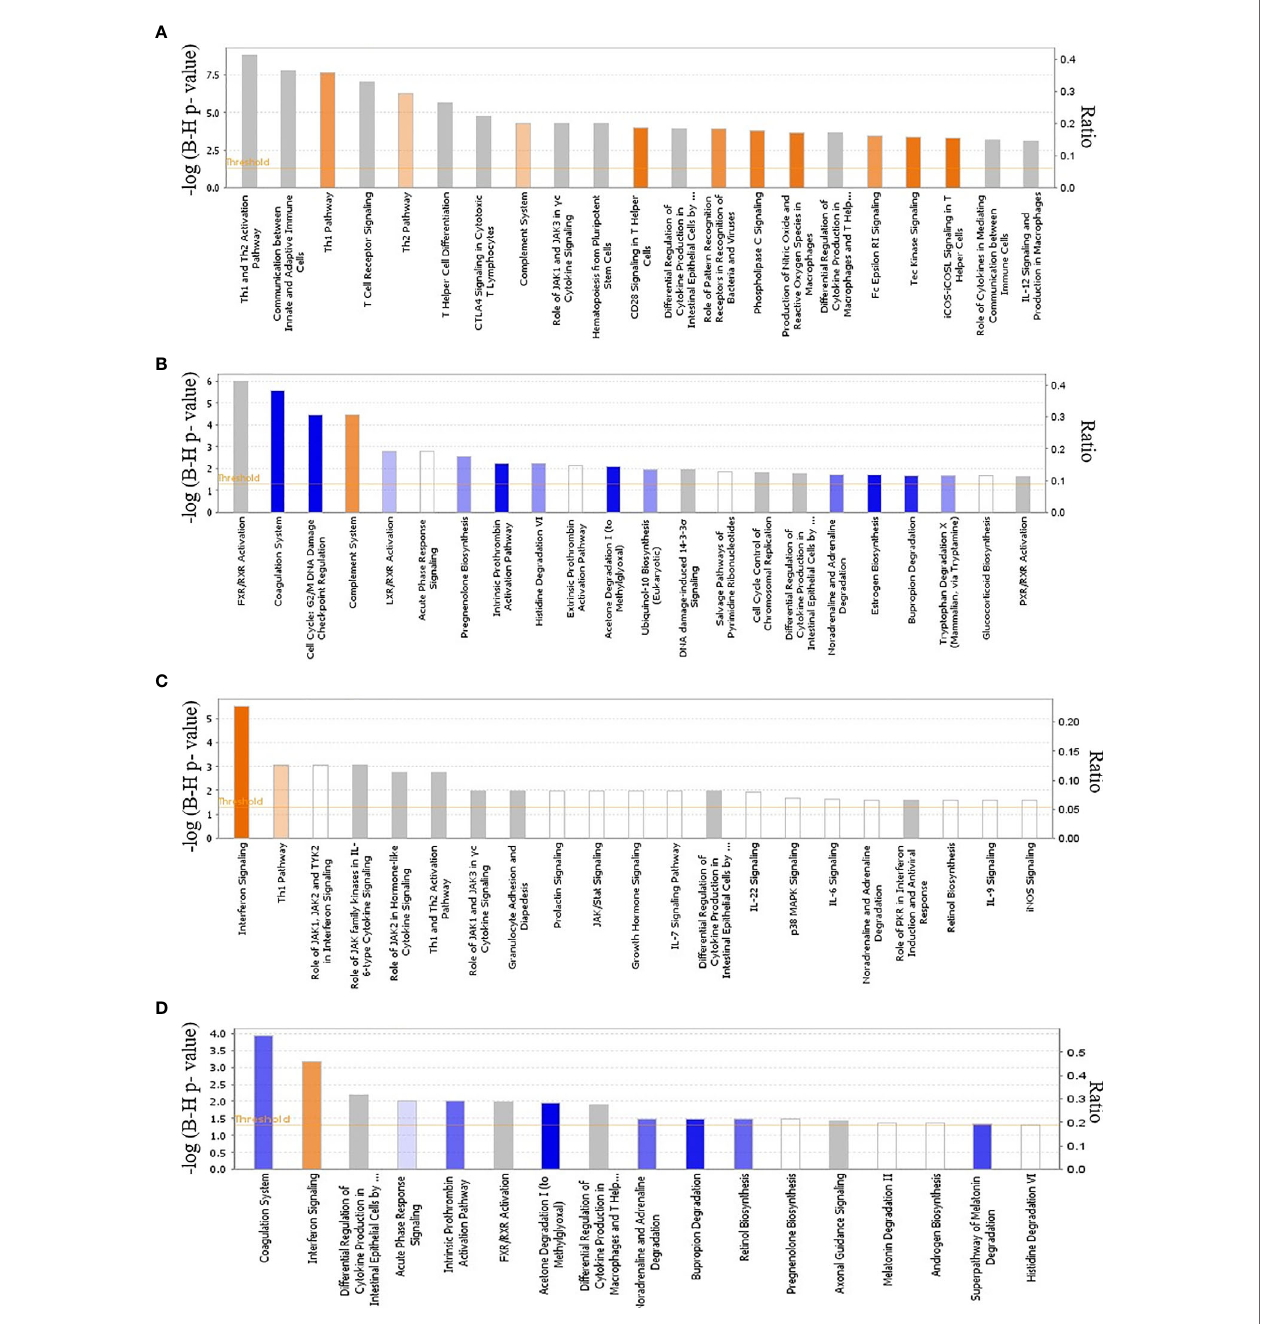
FIGURE 3 | Global transcriptional analysis of cellular canonical pathways and physiological functions. Ingenuity pathway analysis during E. maxima infection in line 15I at 6 (A) and 8 (B) dpi and line C.B12 chickens at 4 (C) and 6 (D) dpi. Color based on Z-score with orange indicating activated pathways and blue indicating de-activated